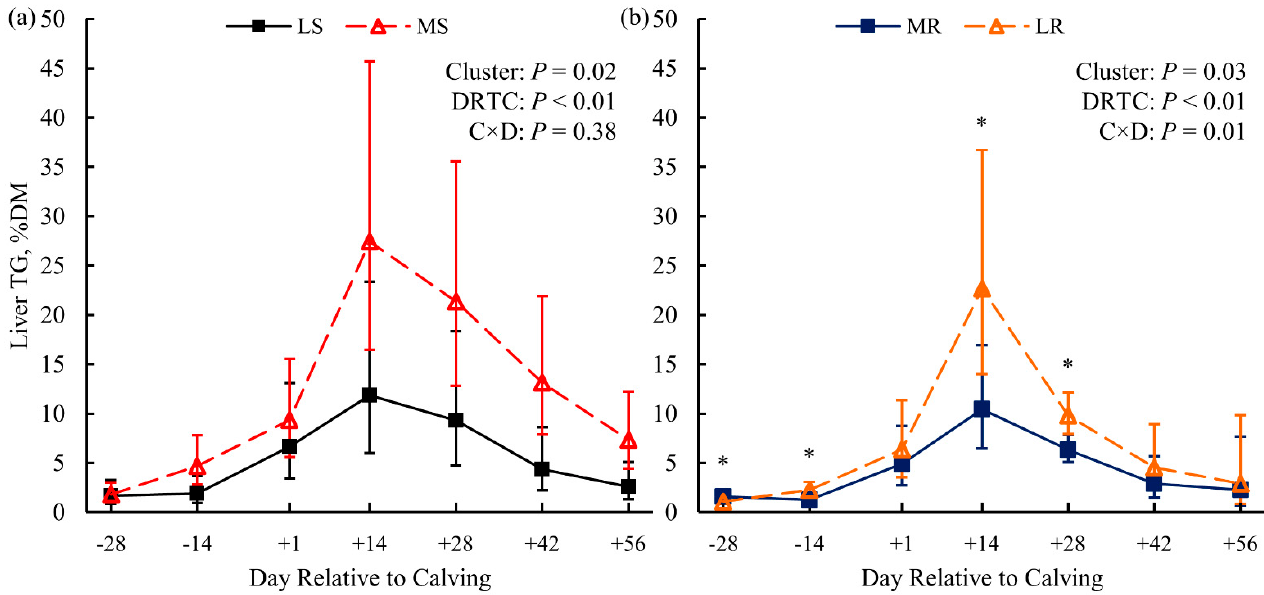
Figure 3. Liver triglyceride (TG) content for dairy cows clustered based on postpartum lipid metabolites within the original dietary treatment. Panel ( a ) depicts cows less (LS) or more (MS) susceptible to lipid-related metabolic disorders, while panel ( b ) compares cows more (MR) or less (LR) resistant to lipid-related metabolic disorders ( n = 3 cows per cluster). Data are presented as least squares means (points) and their 95% confidence intervals (error bars). Statistics for the fixed effects of cluster, day relative to calving (DRTC), and their interaction (C × D) are displayed in the top-right corner of each panel. Significant evidence (*, p ≤ 0.02; Bonferroni adjusted) for simple effects of cluster within DRTC are indicated in their respective panels.